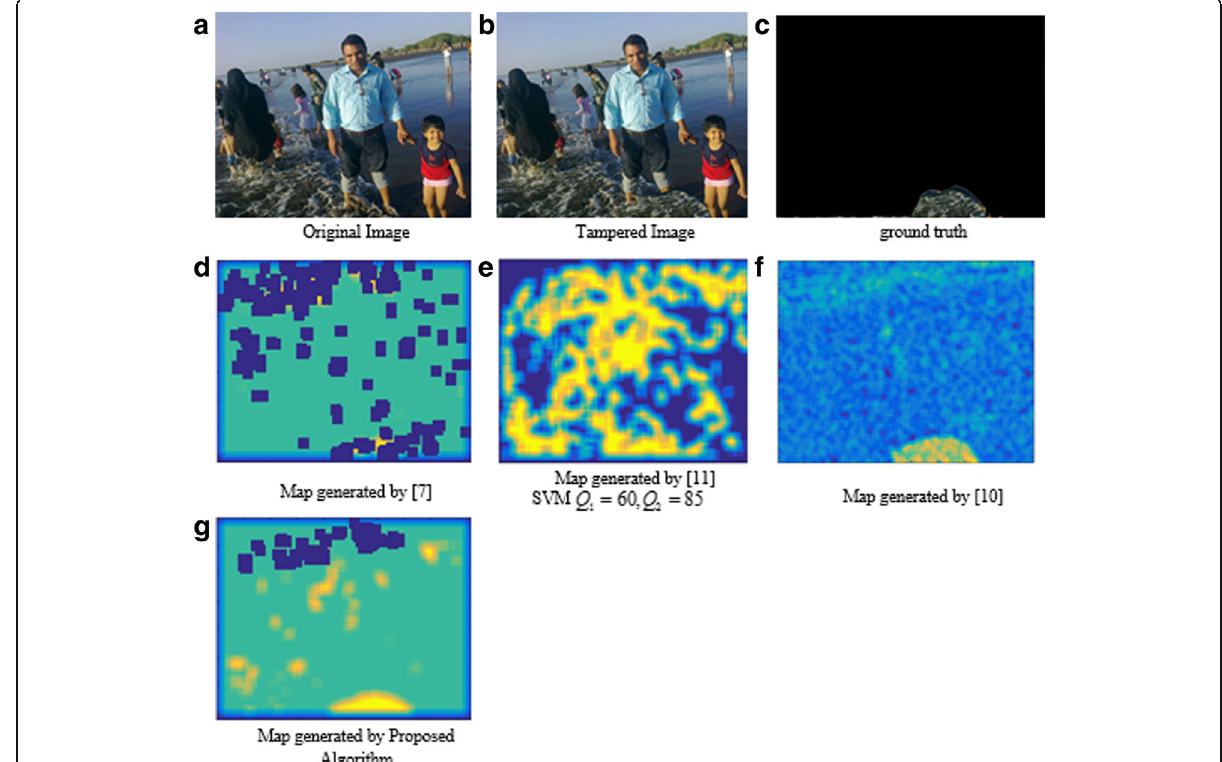
Fig. 6 a – g Tampering localization in self-created tampered